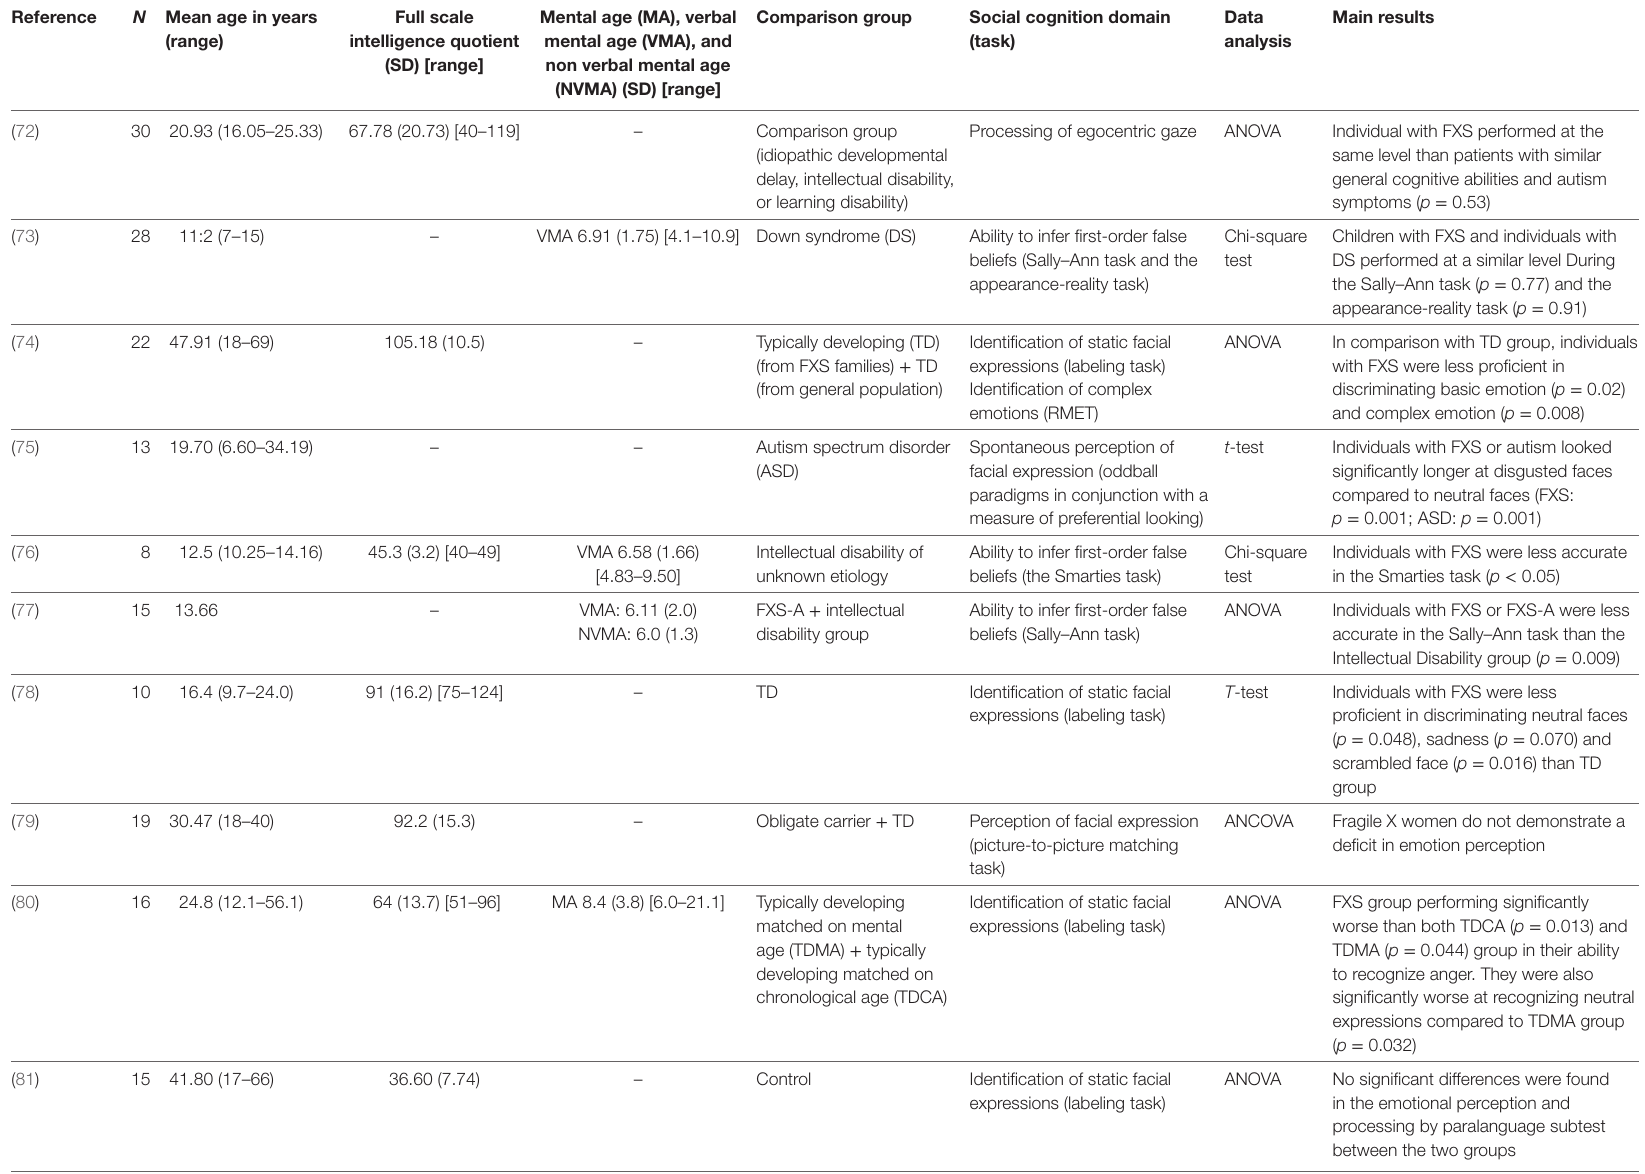
TAbLe 3 | Studies examining social cognition in Fragile X syndrome